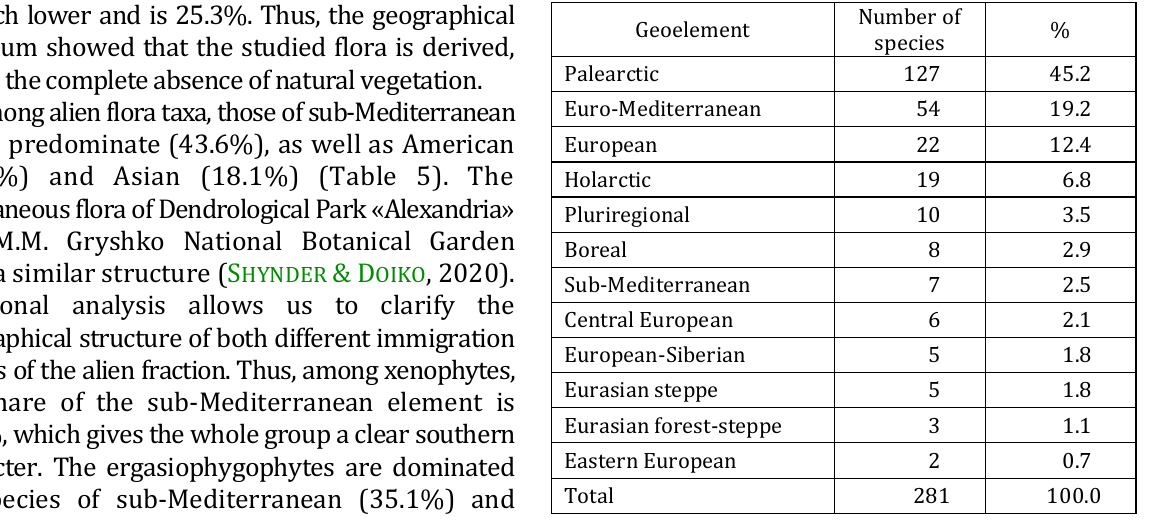
Table 5. Geographical structure of the alien fraction of the flora of the Botanical Garden